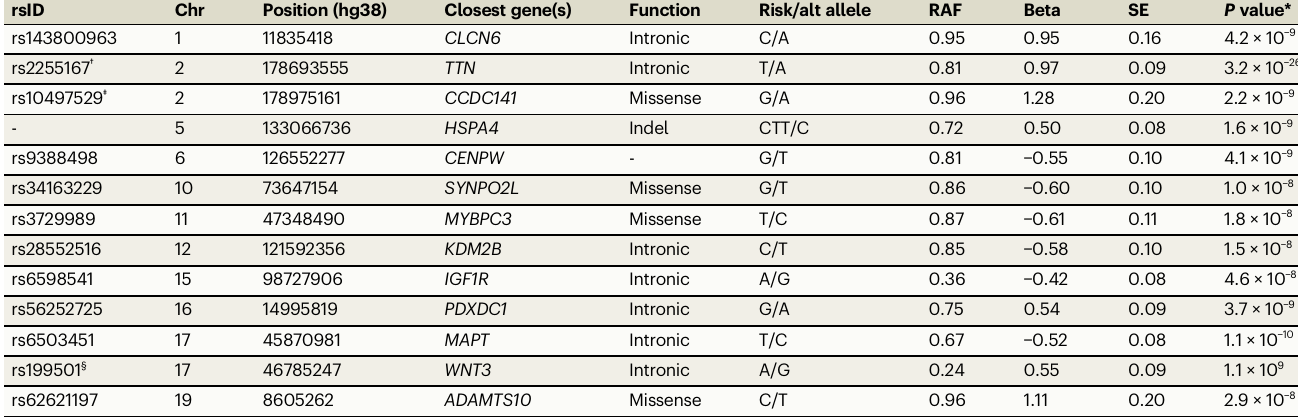
Table 1 | Variants associated with CMR-derived left ventricular mass index in the mixed-ancestry GWAS